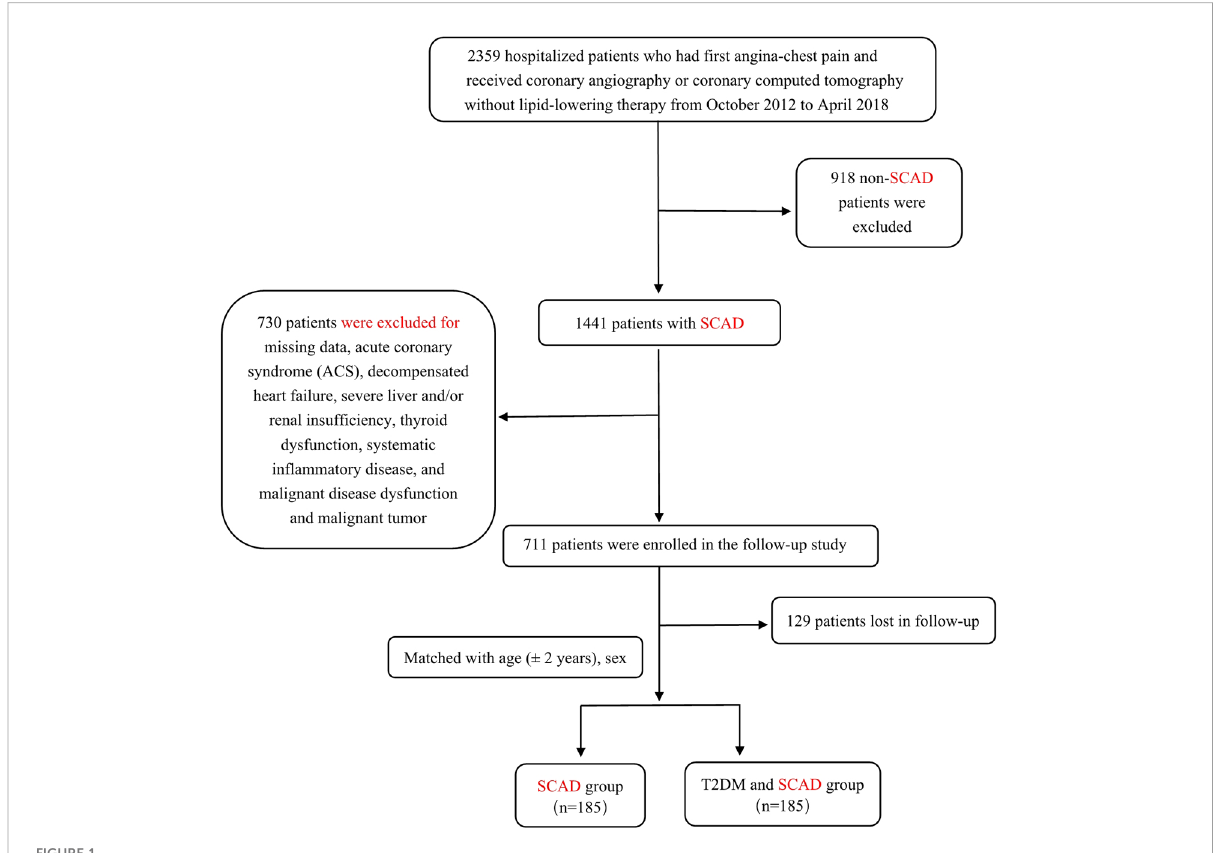
FIGURE 1 Flow chart of patient selection and